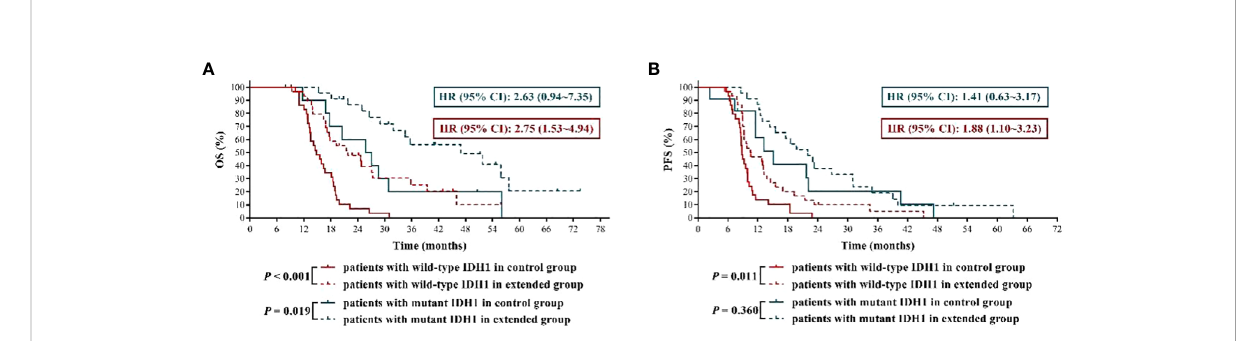
FIGURE 4 The effects of extended adjuvant temozolomide chemotherapy on the clinical outcomes of newly diagnosed glioblastoma patients with different isocitrate dehydrogenase 1 mutation statuses. (A) The Kaplan − Meier survival curves for overall survival. (B) The Kaplan − Meier survival curves for progression-free